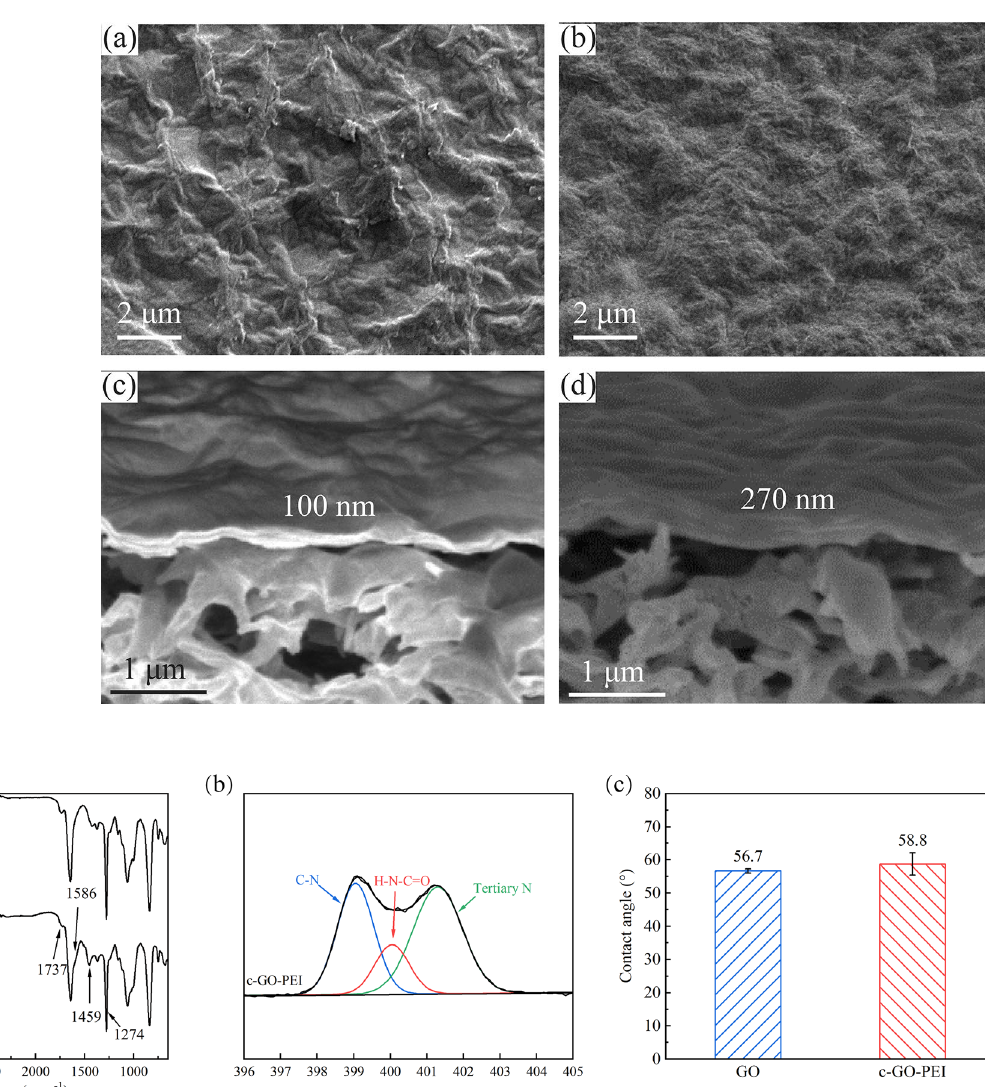
Fig. 2 SEM images of pristine GO and c-GO-PEI membranes